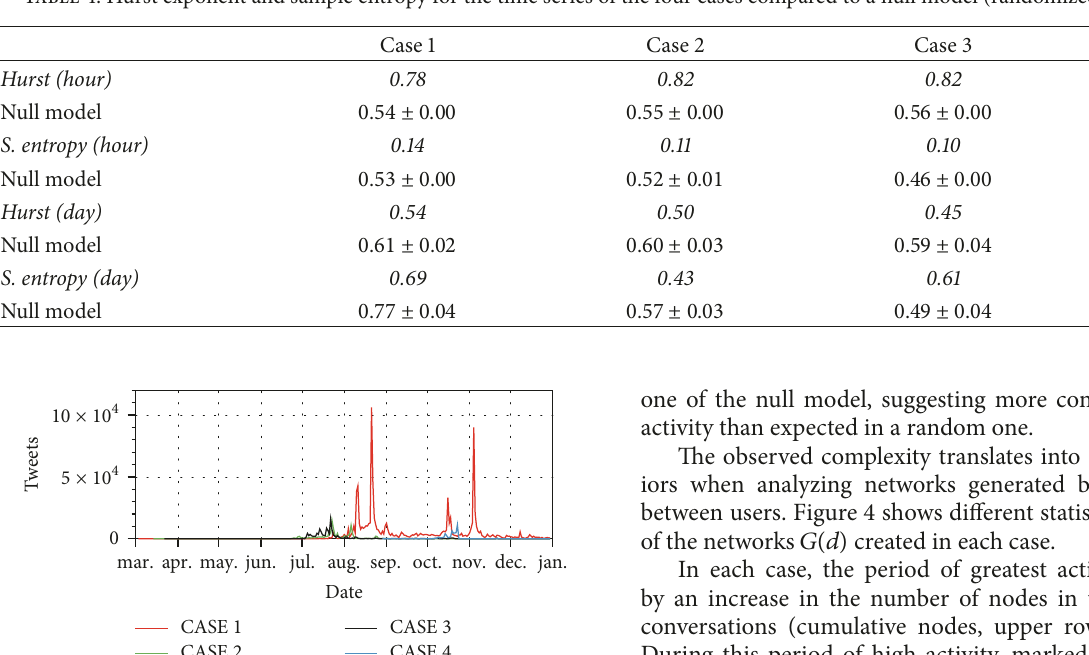
Table 4: Hurst exponent and sample entropy for the time series of the four cases compared to a null model (randomized time series).